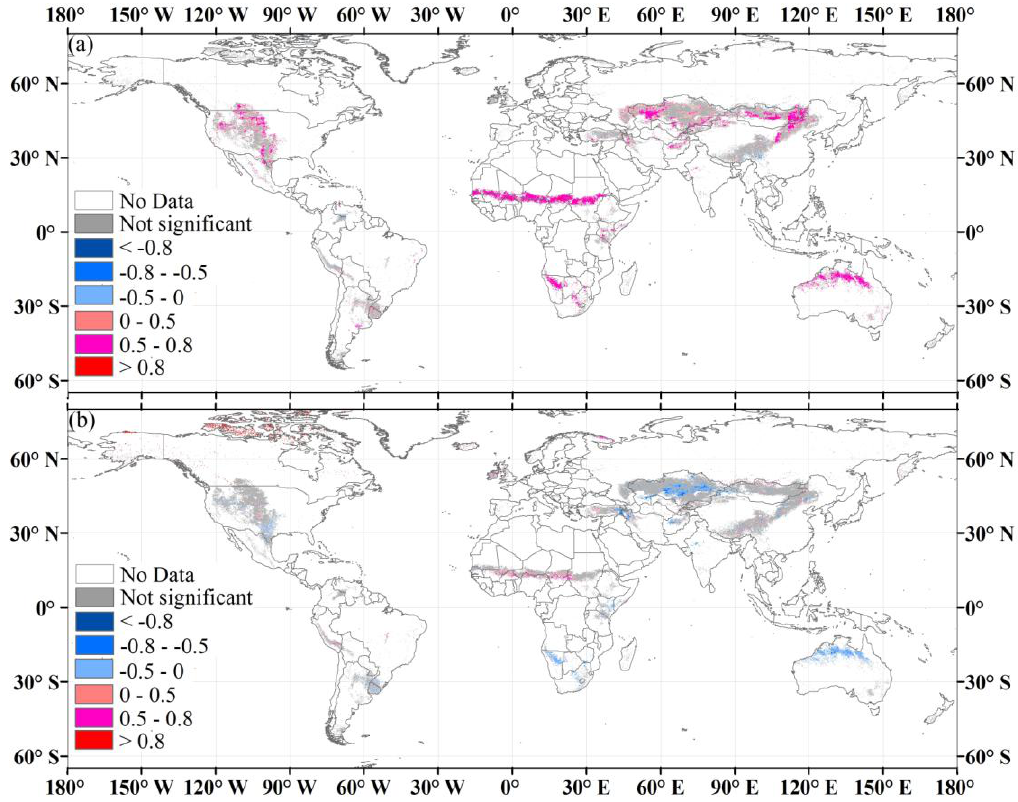
Figure 6. Pearson’s correlation coefficients between annual precipitation and aboveground biomass carbon density ( a ), and between annual mean temperature and aboveground biomass carbon density ( b